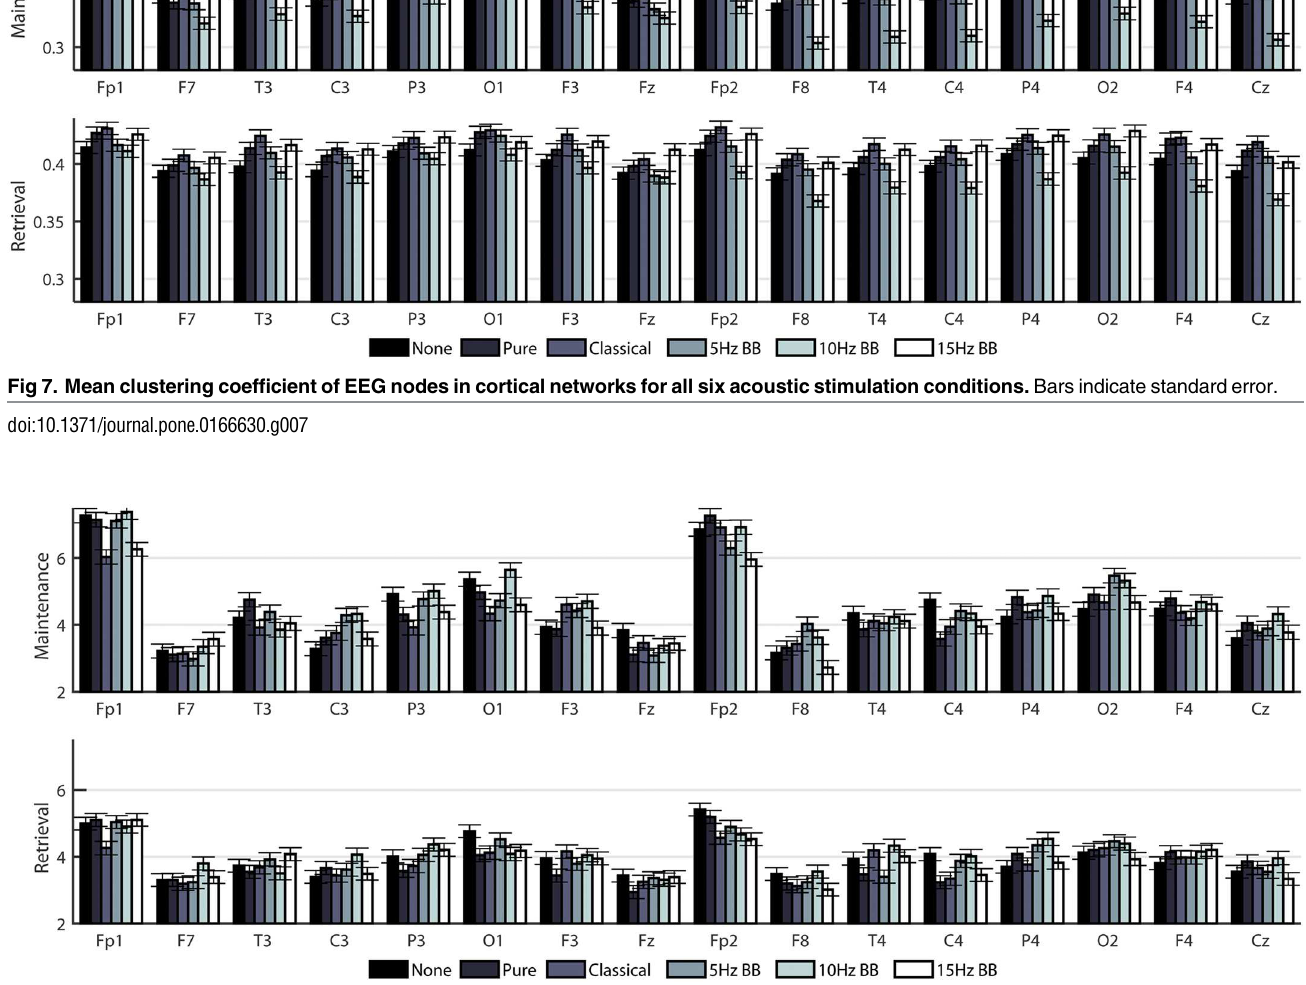
PLOS ONE | DOI:10.1371/journal.pone.0166630 November28,